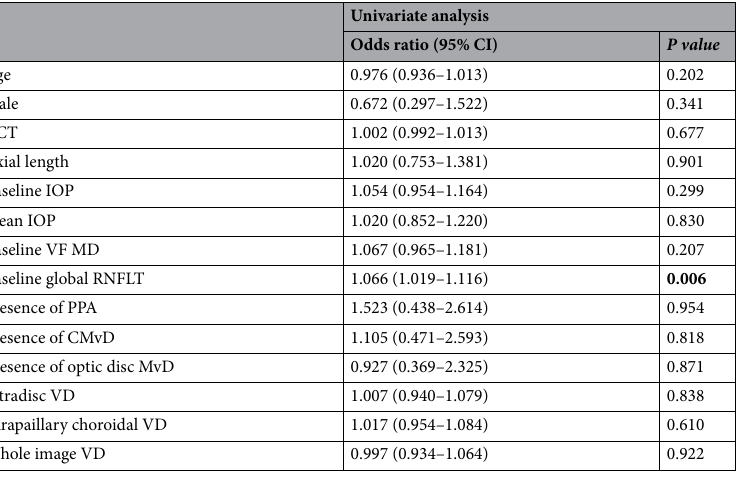
Table 4. Univariate logistic regression analysis for clinical factors associated with recurrence of optic disc hemorrhage during follow-up in eyes with primary open-angle glaucoma. CI confidence interval, CCT central corneal thickness, IOP intraocular pressure, VF visual field, MD mean deviation, RNFLT retinal nerve fiber layer thickness, PPA parapapillary atrophy, CMvD choroidal microvascular dropout, MvD microvascular dropout, VD vessel density. Significant values are in